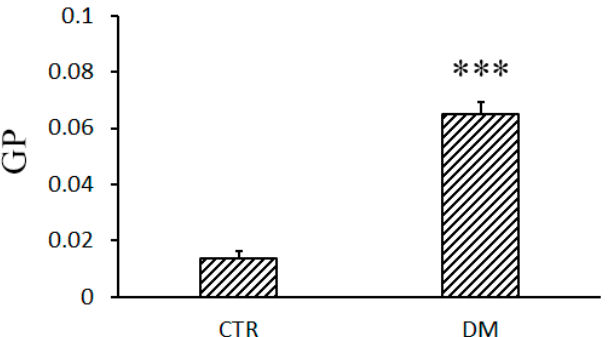
Figure 5. Effect of diabetes mellitus on the opening of palmitate/Ca 2+ -induced lipid pores in rat liver mitochondria. ( A ) Absorbance changes in the suspension of liver mitochondria of control (trace 1) and STZ-treated (trace 2) rats in response to the addition of 20 μ M palmitic acid (Pal) and 30 μ M Ca 2+ . ( B ) The rate of CsA-insensitive palmitate/Ca 2+ -induced swelling of liver mitochondria in control (curve 1) and diabetic (curve 2) rats versus palmitic acid concentration. The incubation medium contained 210mM mannitol, 70mM sucrose, 5mM succinate, 10 μ M EGTA, 1 μ M rotenone, 1 μ M CsA, and 10mM Hepes/KOH buffer, pH 7.4. Additions: 30 μ M Ca 2+ . The concentration of mitochondrial protein was 0.4 mg/mL. Values are given as means ± SEM ( n = 5). * p < 0.05 compared to controls.